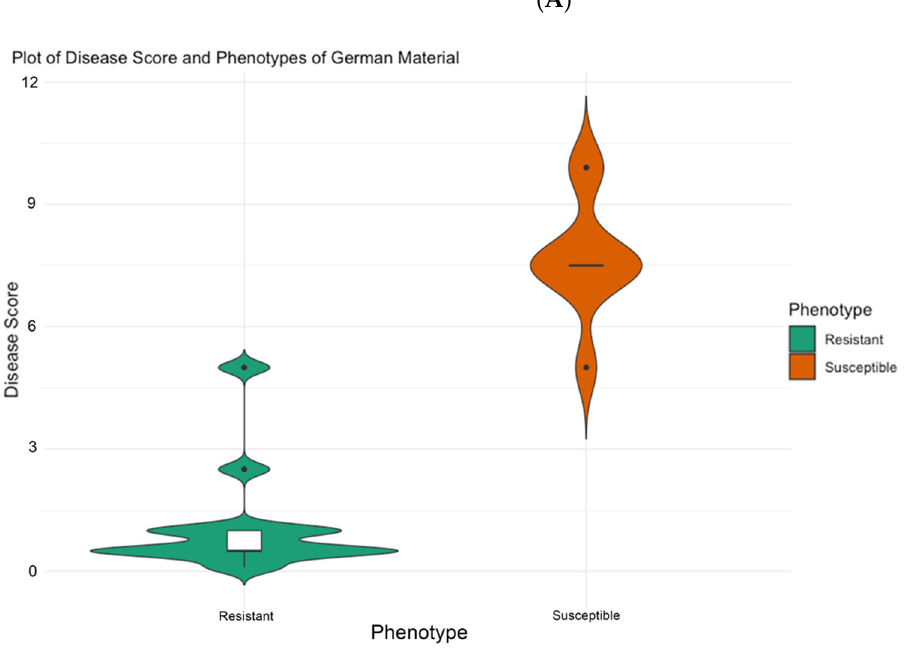
Figure 2. ( A ) Distribution of disease severity [2] scores across tested germplasm from Germany. The range of variation for plants from each variety classified as resistant and susceptible is shown. ( B ) Resistance trait summary plot of material from grouped based on phenotype. The width of the shaded area can be correlated with the density of the data points.